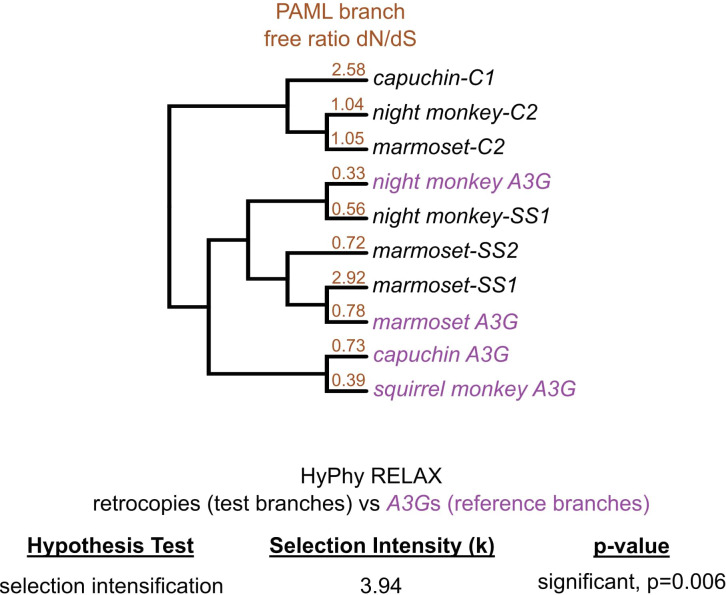
Analysis of selection in the evolution of retrocopies.Top, PAML free ratio analysis of selection along branches (omega values for terminal branches shown in orange). Omega values less than one for all terminal branches leading to A3Gs suggest these genes have evolved under purifying selection. The branches leading to the two retrocopies that restrict retrovirus have elevated omega values (significantly higher than dN/dS = 1, p=0.058 for capuchin-C1, p=0.025 for marmoset-SS1) suggesting these retrocopies have evolved under positive selection. Bottom, RELAX analysis of overall selection when comparing A3Gs (purple) to A3G retrocopies (black) suggests the retrocopies have evolved under intensified selection (no detection of relaxation of selection) relative to the presumably functional A3Gs.